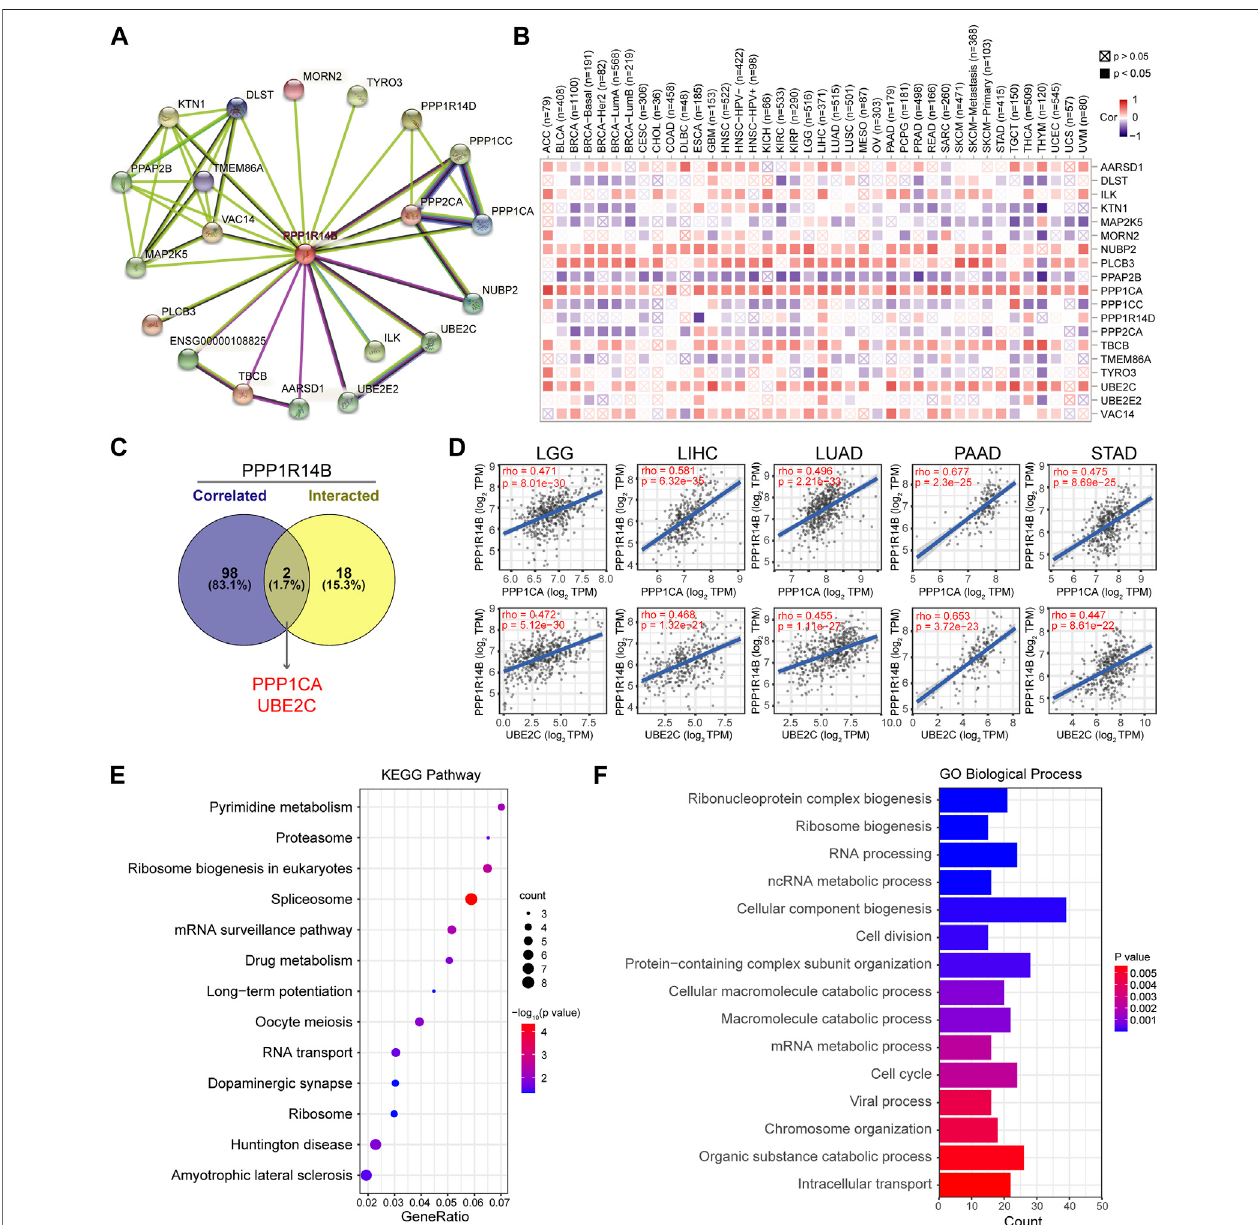
FIGURE 7 | PPP1R14B-related gene enrichment analysis. (A) PPP1R14B interaction network analysis. (B) Correlation of PPP1R14B with the 20 interactors of PPP1R14B-binding. (C) Intersection analysis of PPP1R14B-correlated genes and PPP1R14B-interacted partners. (D) Correlations of PPP1R14B with PPP1CA and UBE2C. (E) KEGG enrichment analysis based on the PPP1R14B-correlated and interacted genes. (F) GO analysis based on the PPP1R14B-binding and interacting genes.